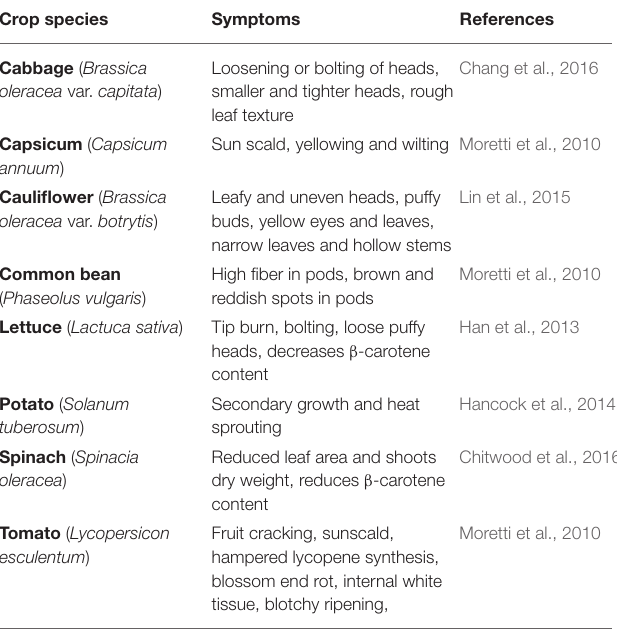
TABLE 2 | Noticeable symptoms of heat stress in some vegetable crops. Crop